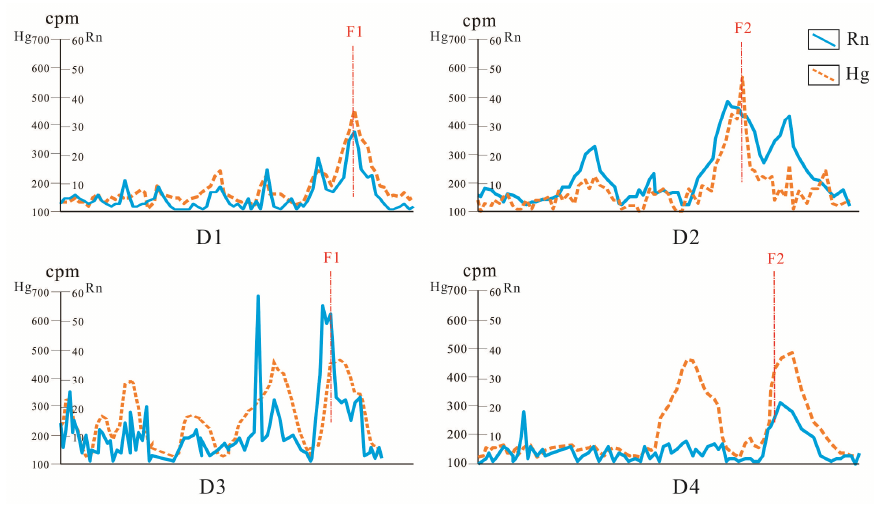
Figure 8. Rn and Hg detection results.